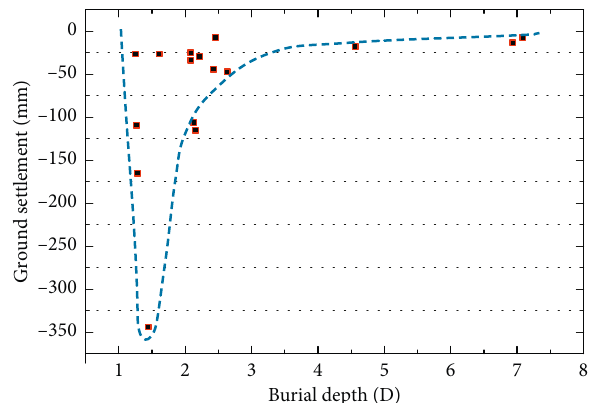
Figure 15: Distribution of ground settlement with ratio of burial depth to tunnel span